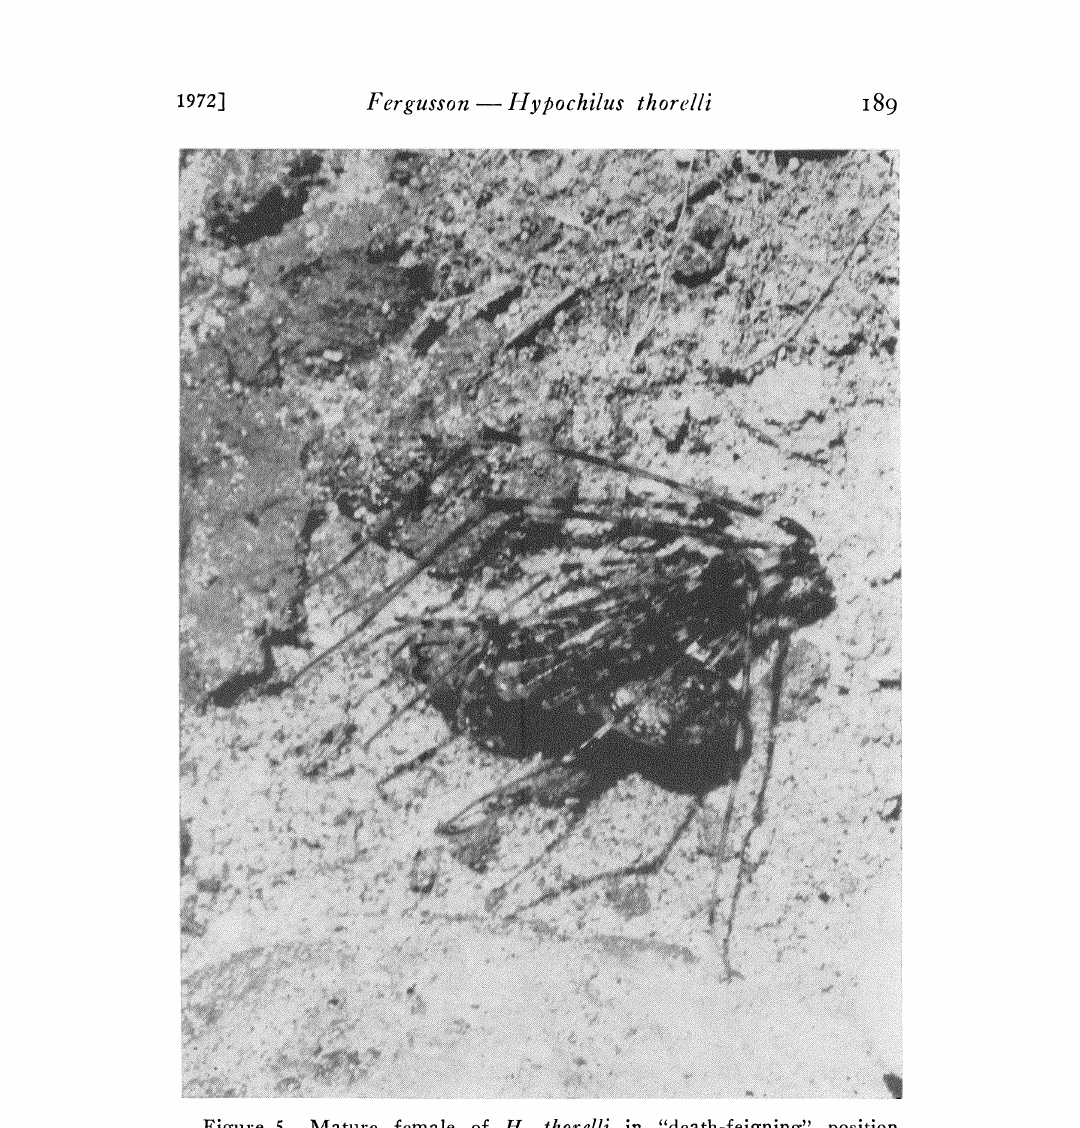
Figure 5. Mature female of H. thorelli in death-feigning position. The legs of this specimen are less tightly flexed than usual, since the spider had to be moved in order to obtain the photo. Photo by L.